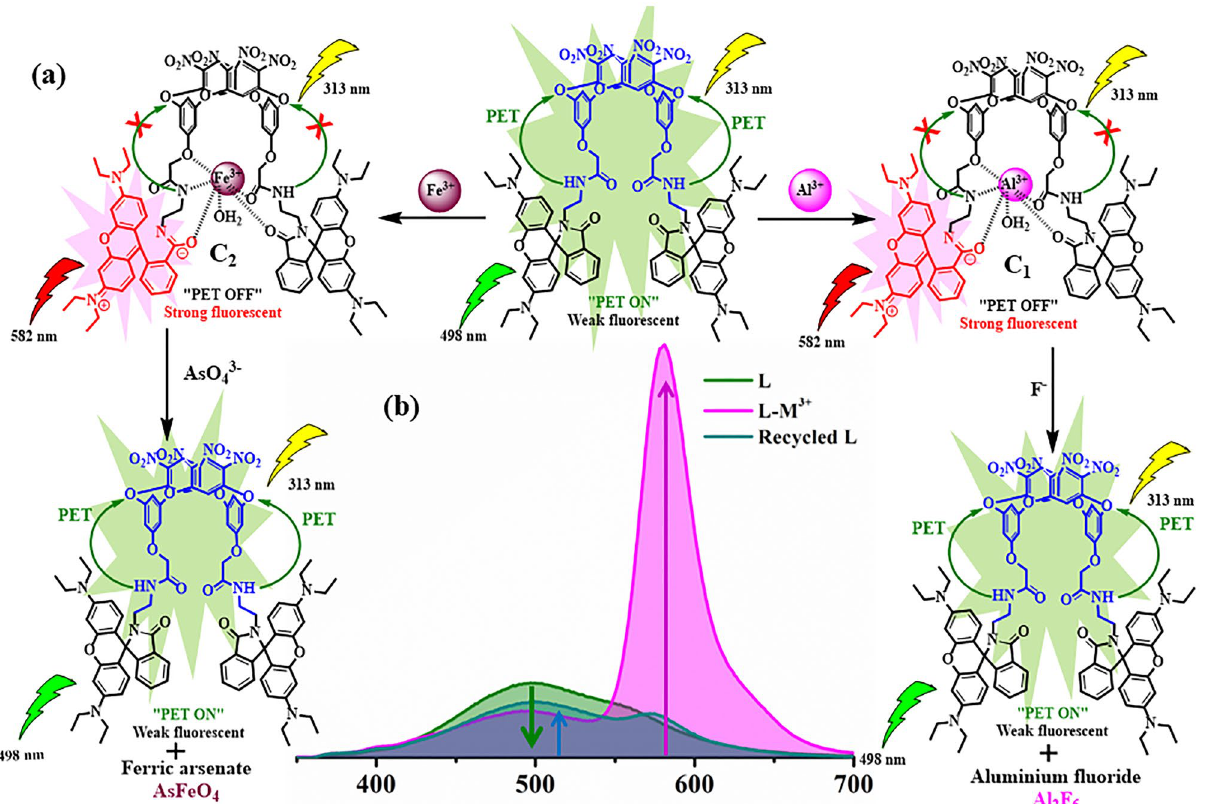
Figure 9. Plausible sensing mechanism of L toward Al 3+ / Fe 3+ , C 1 toward Fluoride and C 2 toward AsO 4 3− .